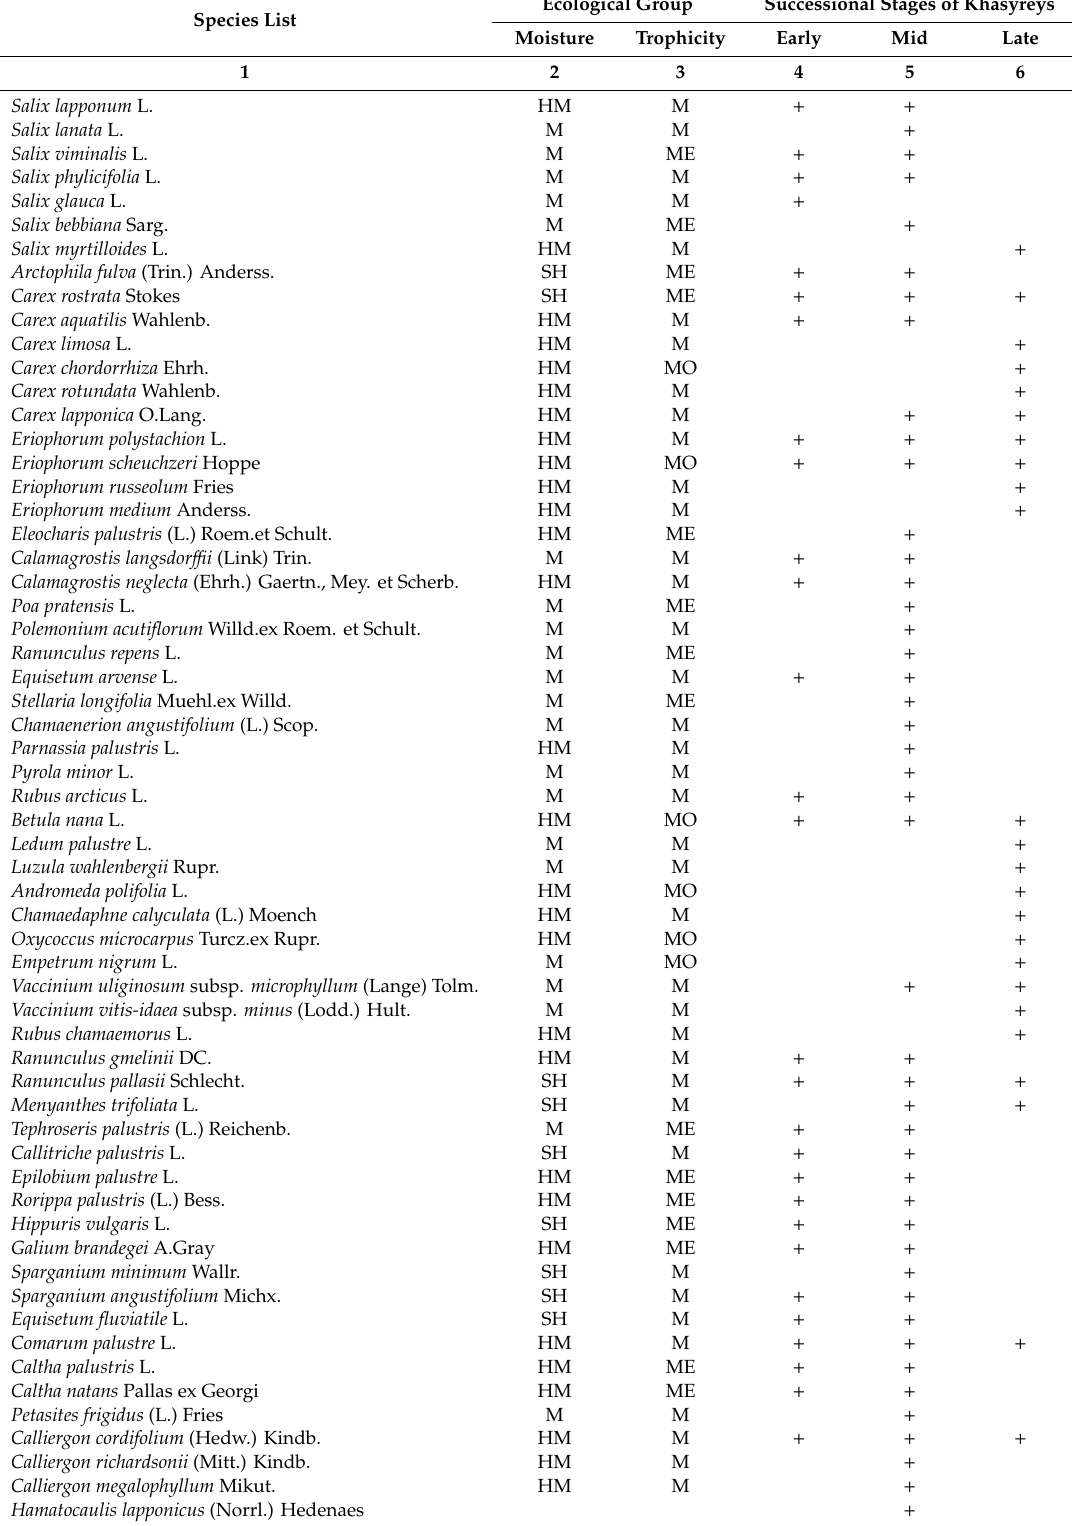
Table A1. List of plant species found in the khasyreys of the Pur-Taz interfluve. Ecological Group Successional Stages of Khasyreys Species List Moisture Trophicity Early Mid